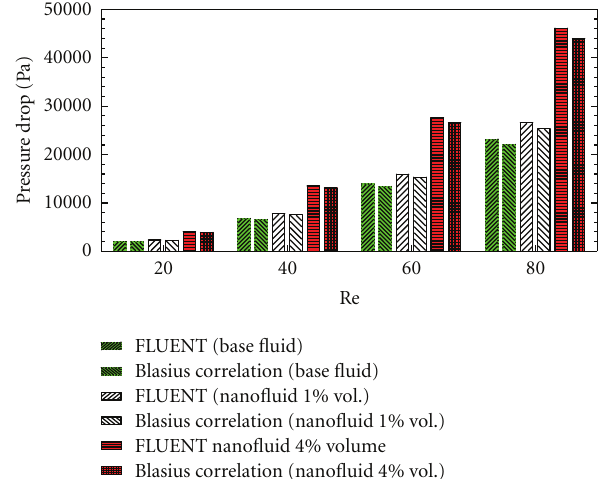
Pak and Cho [1] (0% vol.) Pak and Cho [1] (1% vol.) Figure 10: Di ff erences of FLUENT result from experimental cor- relations proposed by Pak and Cho [1] and numerical correlation proposed by Ma¨ıga et al. [9].